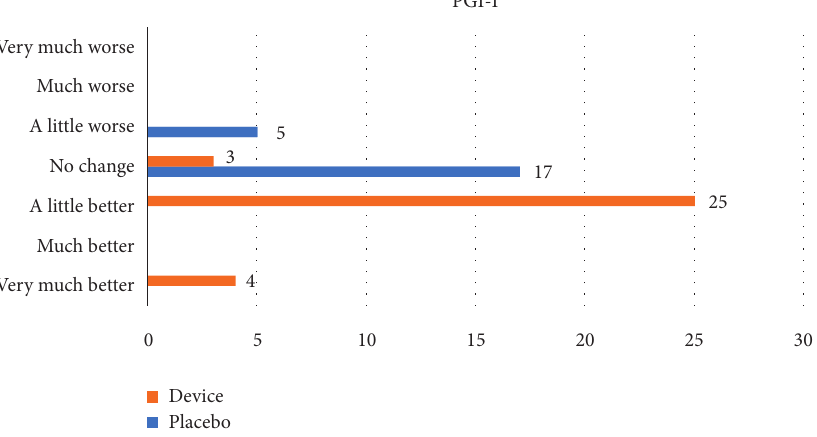
Figure 5: Patients’ impression of the effectiveness of treatment according to the PGI-I Scale.